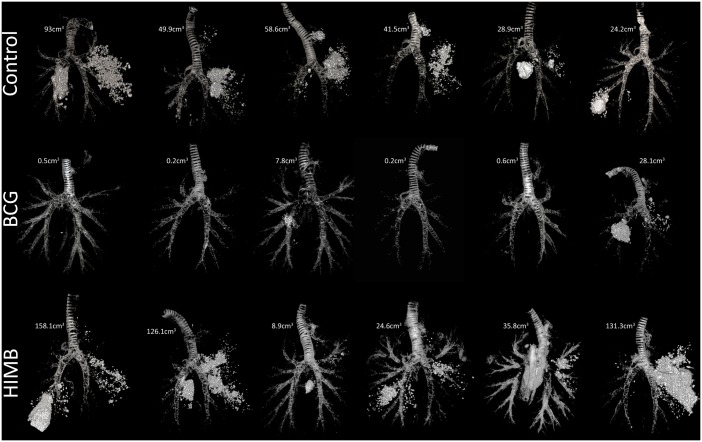
Individual volume of pulmonary gross lesions measured by computed tomography (CT).The figure shows rendering images of the total lesion volume (expressed in cm3) for each lung of the 6 unvaccinated control, 6 BCG vaccinated and 6 HIMB vaccinated lambs. The trachea and the bronchial tree are also displayed for anatomical reference.